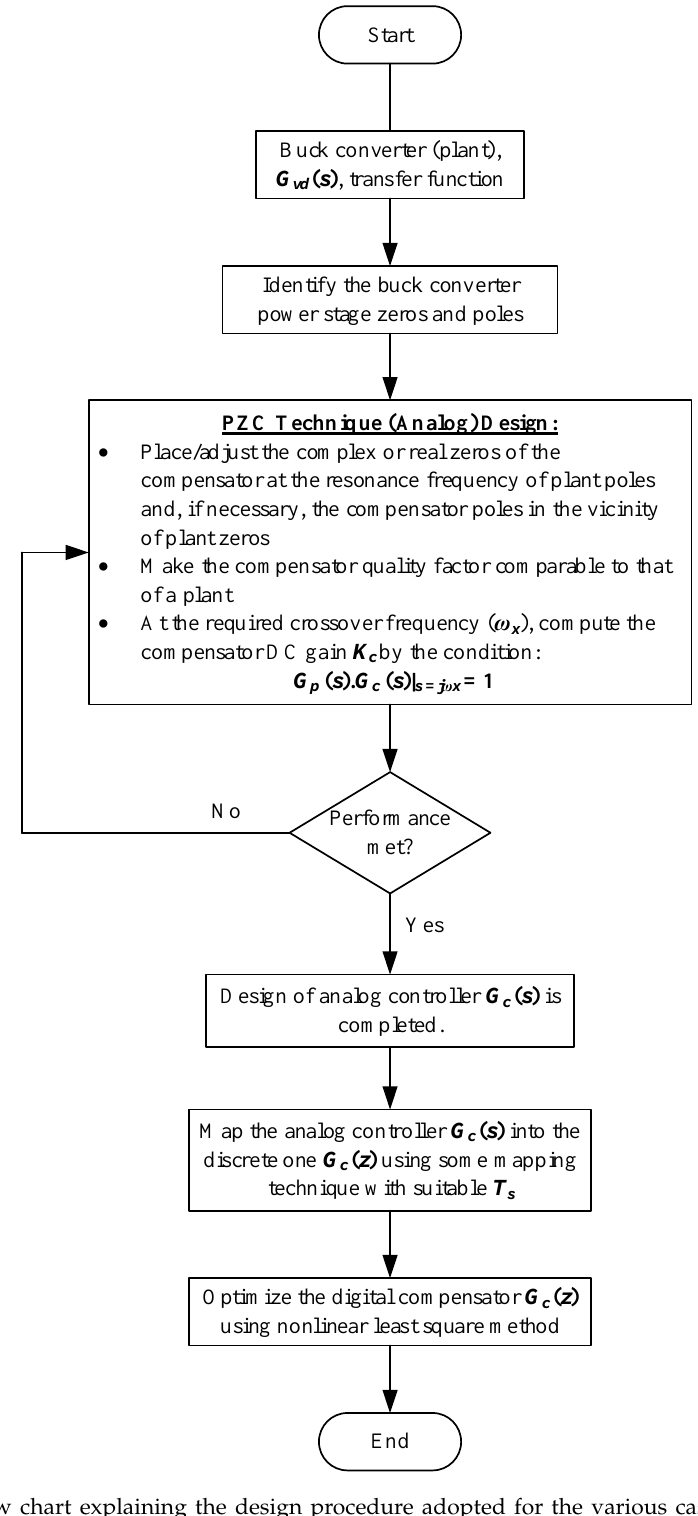
Figure 3. Flow chart explaining the design procedure adopted for the various cases. PZC: pole-